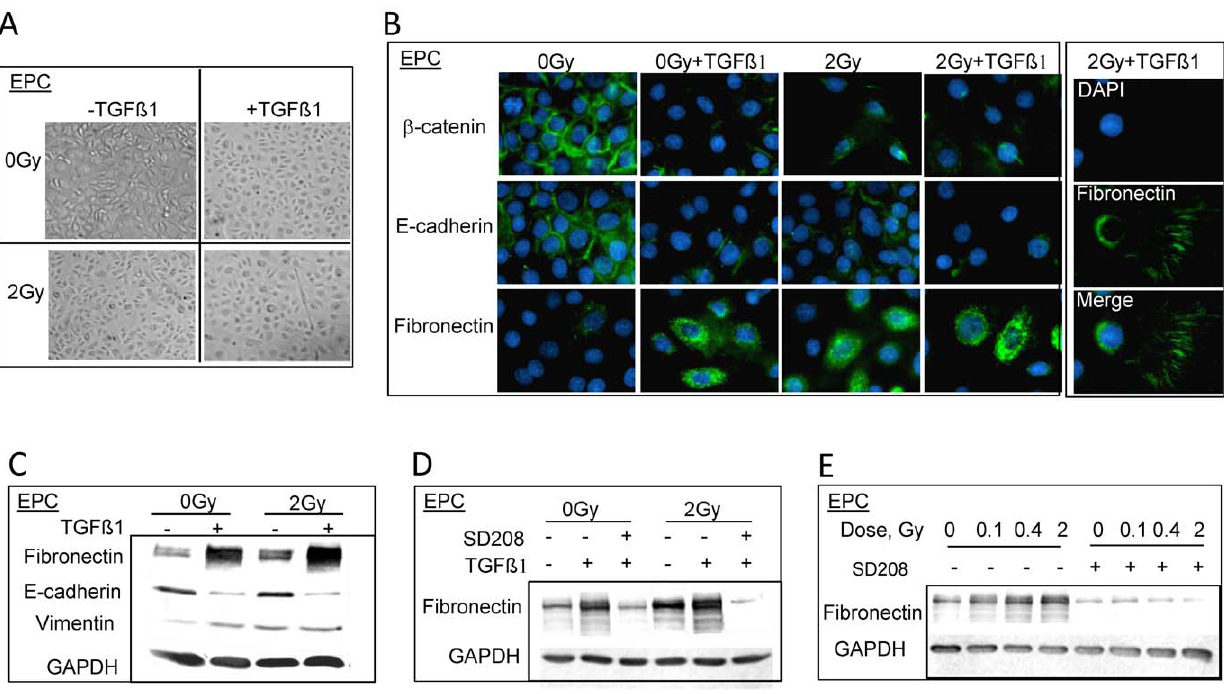
Figure 3. Protons enhance EMT induced by TGF b 1 in EPC cells. A. Phase contrast images of morphology alterations after double treatment of TGF b 1 and 2 Gy of protons. B. Immunostaining of EMT markers, 3 days post 2 Gy of protons in the presence or absence of TGF b 1. Right panel shows the tracks of fibronectin staining in EPC cells after double treatment. C. Western blots show the change of EMT markers expression upon TGF b 1 and/ or protons treatment. Whole cell extracts were prepared using RIPA buffer. D. Western blots show the inhibition of fibronectin expression when EPC cells were pretreated with TGF b R1 inhibitor-SD208 1 h before 2 Gy or 0 Gy of proton radiation. E. The inhibition effect of SD208 on protons treatment